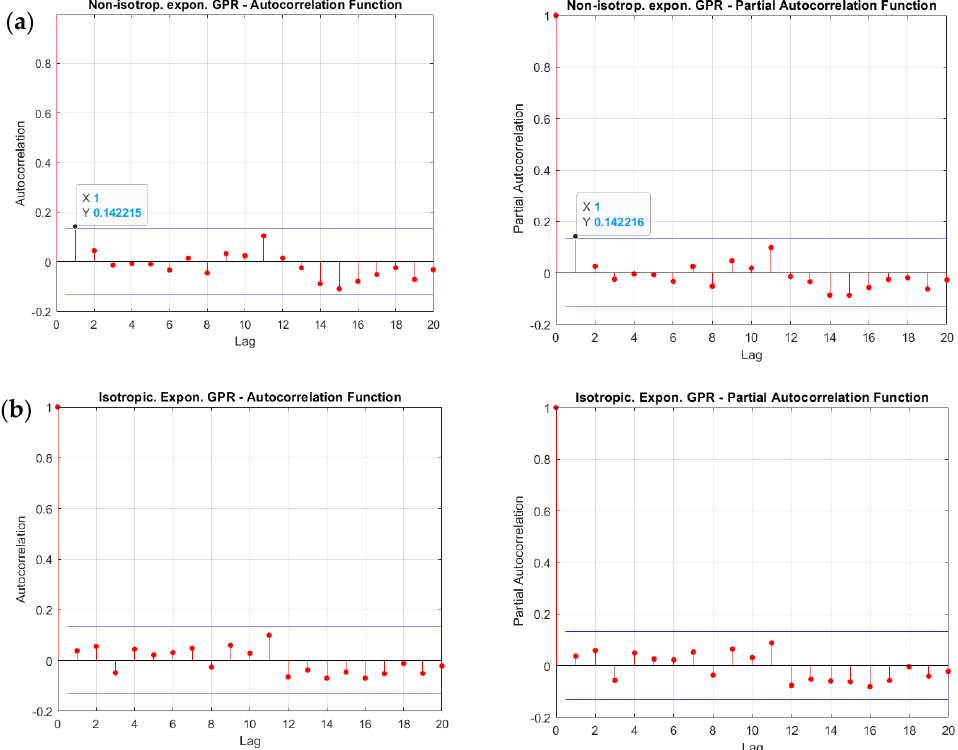
Figure 11. Residuals autocorrelation and partial autocorrelation functions for: ( a ) Non-isotropic exponential GPR, ( b ) Isotropic exponential GPR.